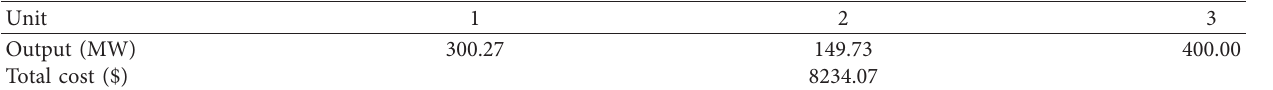
Table 7: Best dispatch obtained by ISSO for 3-unit system with P